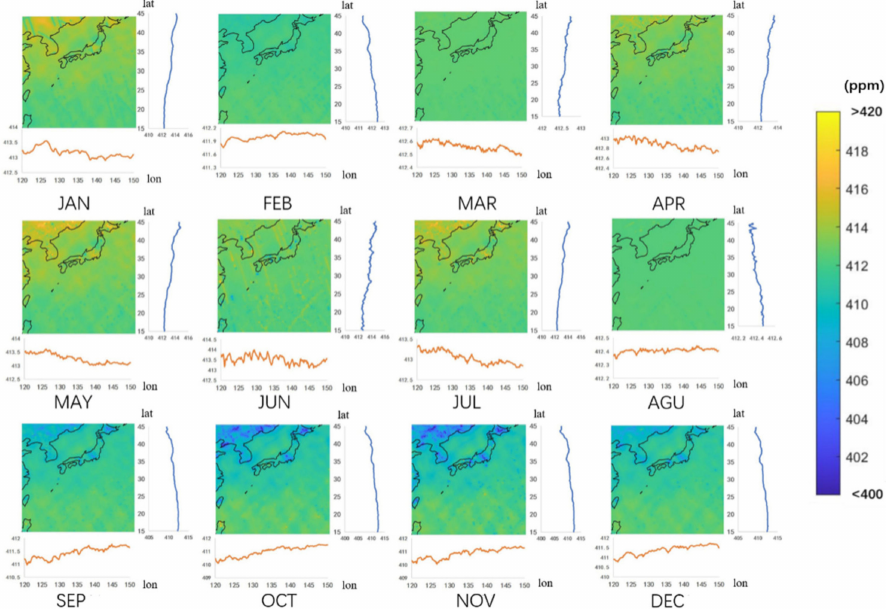
Figure 4. Monthly Interpolation Results of XCO 2 from January to December 2020(The orange line graph at the bottom of the picture represents the longitudinal integration of XCO 2 /ppm, and the blue line graph at the right represents the latitudinal Integration of XCO 2